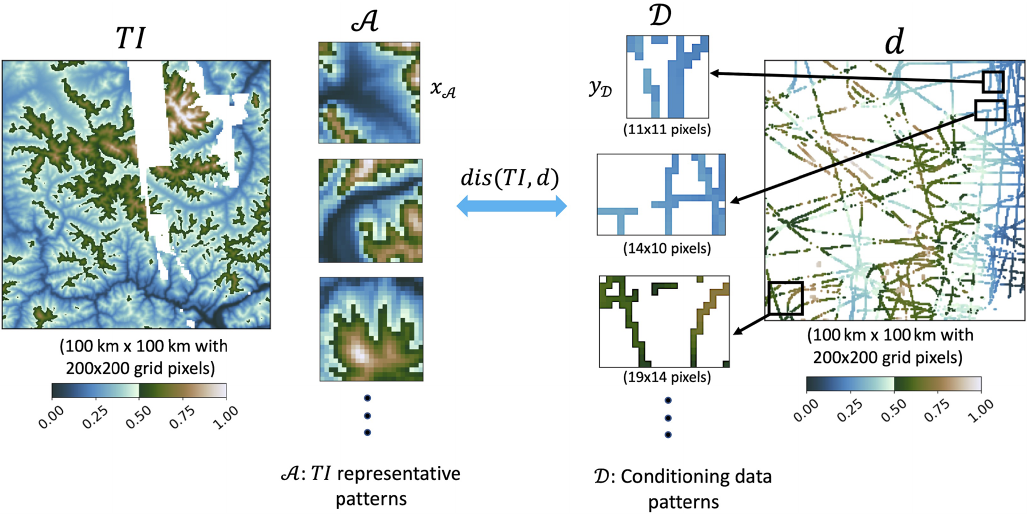
Figure 7. Illustration of measuring the distance between training image and radar line data ( d ) in subarea A 1 . We first extract a group of radar data patterns D from the simulation grid with flexible-sized templates. Then the Hausdorff distances between the representative patterns A and radar patterns D are individually computed. Representative pattern x A has a fixed size of 23 × 23 pixels, while the size of conditioning data pattern y D